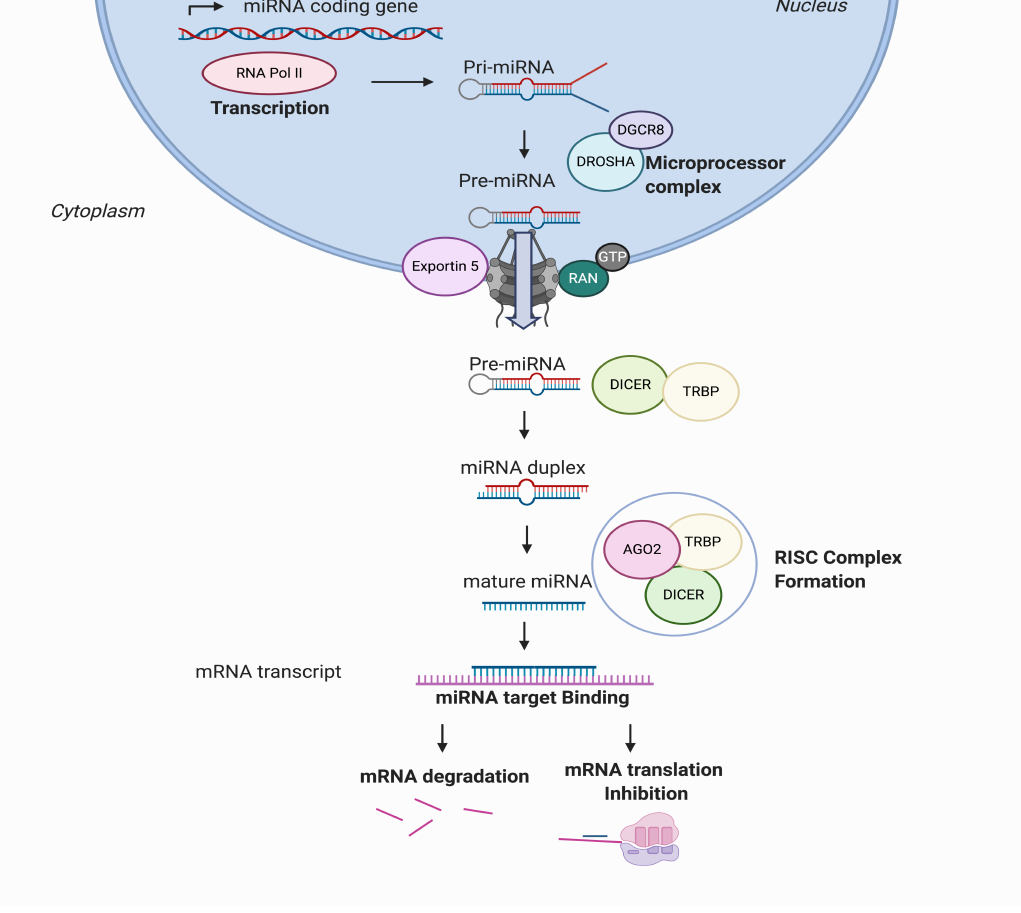
Figure 1. MicroRNA (MiRNA) biogenesis and regulation of gene expression. miRNAs are transcribed from the genome into a pre-miRNA. The pre-miRNA is a smaller stem-looped structure that is transported from the nucleus to the cytoplasm by Exportin 5. Once in the cytoplasm, it is cleaved by DICER and TRBP and results into a small mRNA duplex that is around 20–25 nucleotides of length. The duplex is separated, and one of the strands is incorporated into the RISC, formed by AGO member proteins. The mature miRNA is then generated and binds specifically the mRNA transcript by complementary target recognition. The mRNA–miRNA union prevents the mRNA translation or leads into mRNA degradation and subsequent gene silencing. AGO: argonaute protein family and RISC: RNA-induced silencing complex.